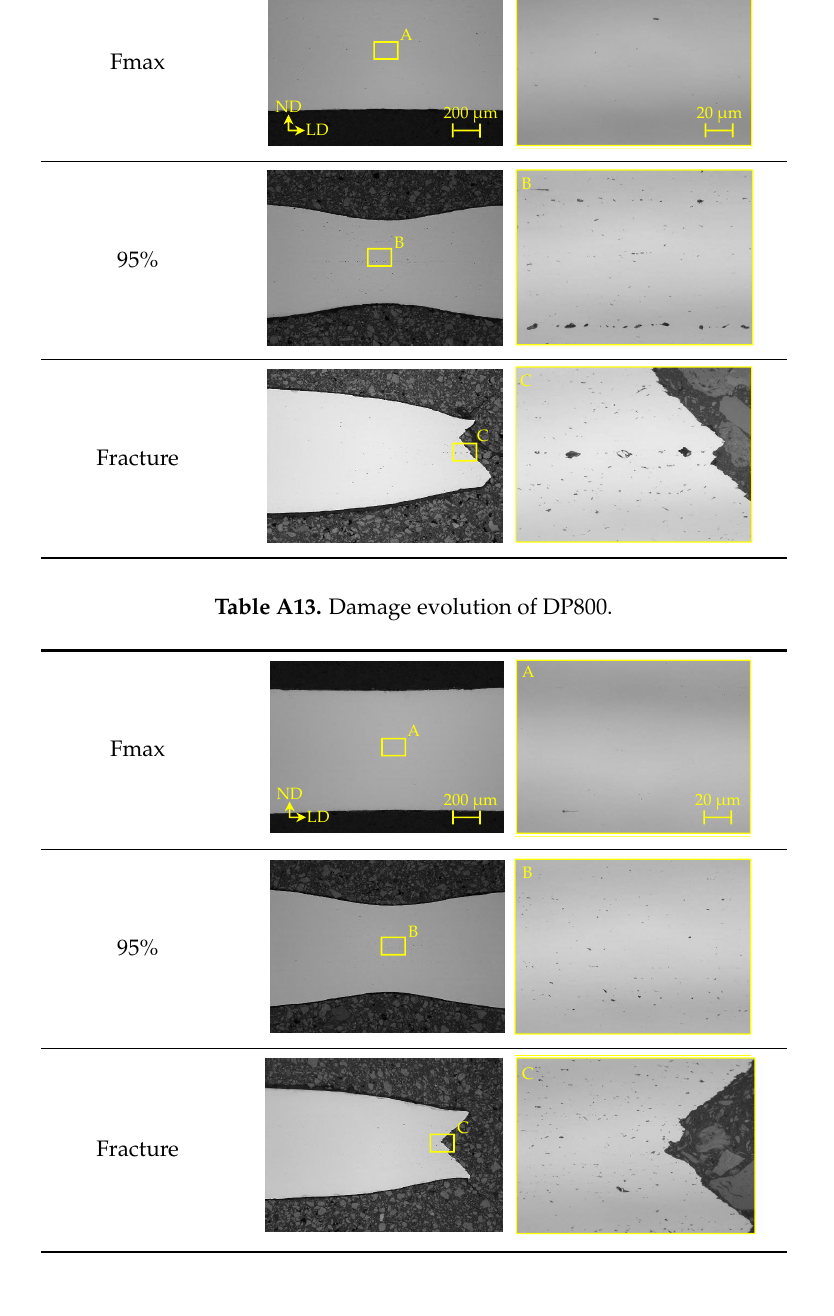
Table A12. Damage evolution of DP600.